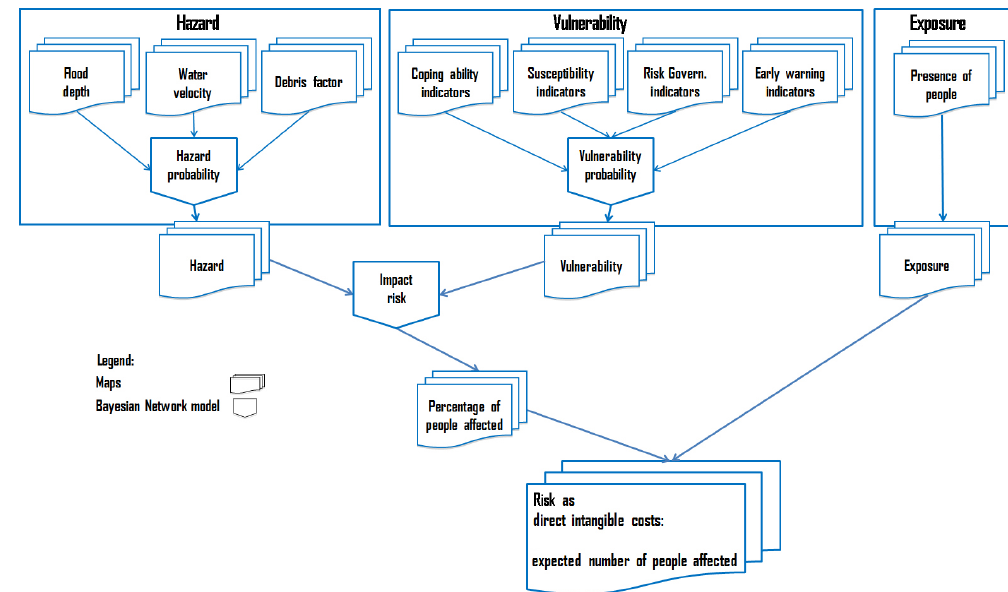
Figure 3. Customized application of the KULTURisk